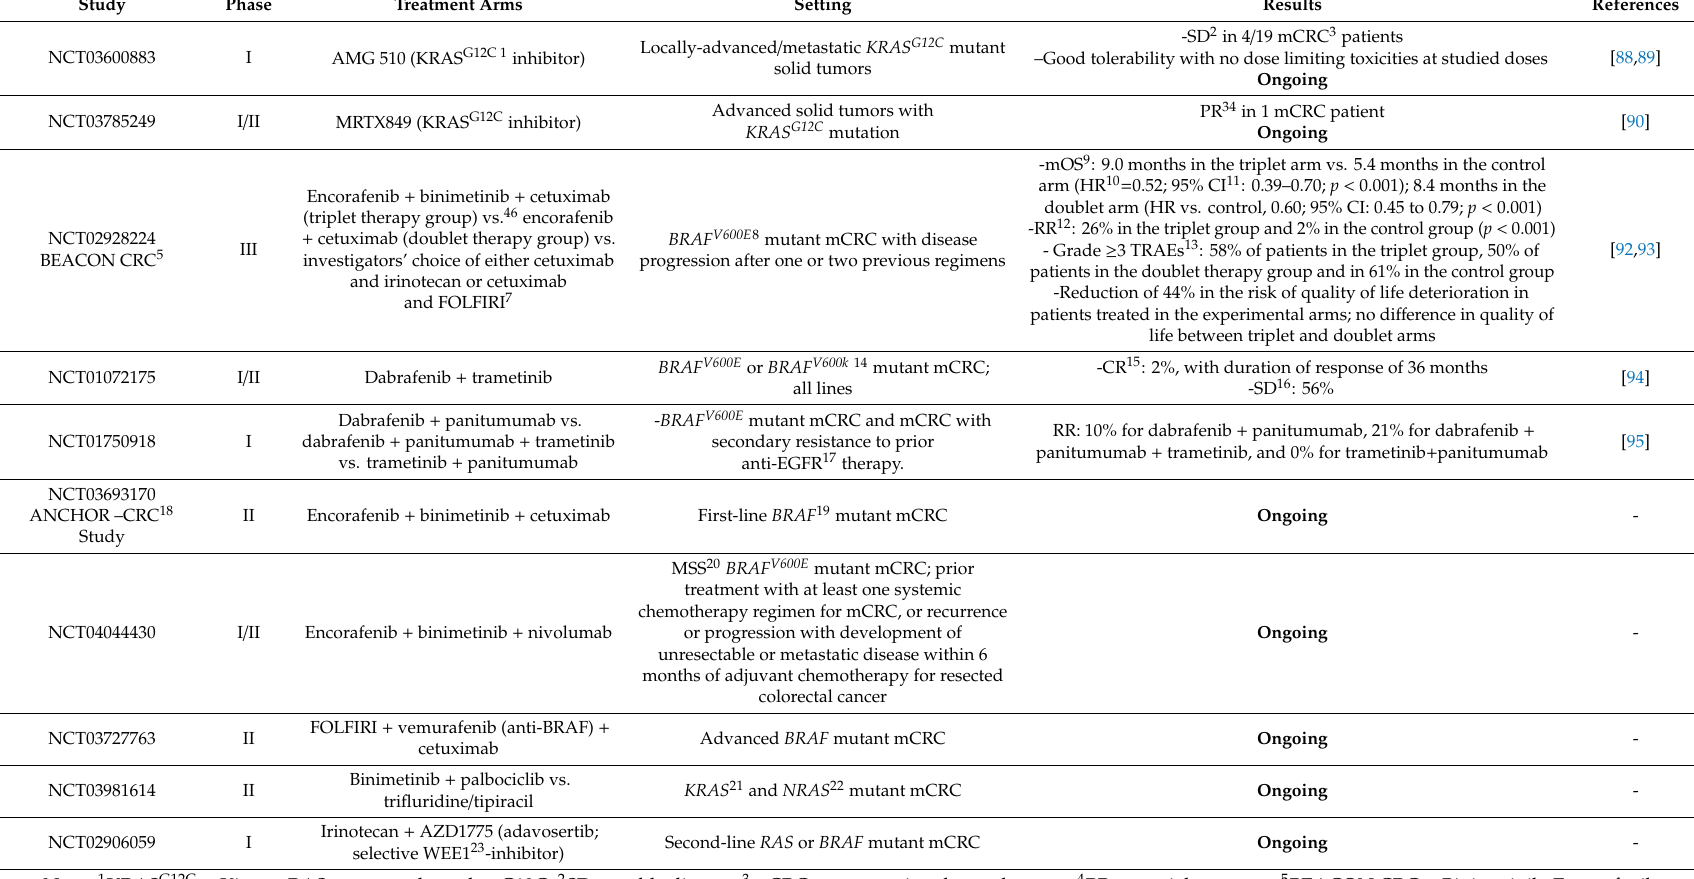
Table 5. Clinical trials targeting the mitogen-activated protein kinase (MAPK)